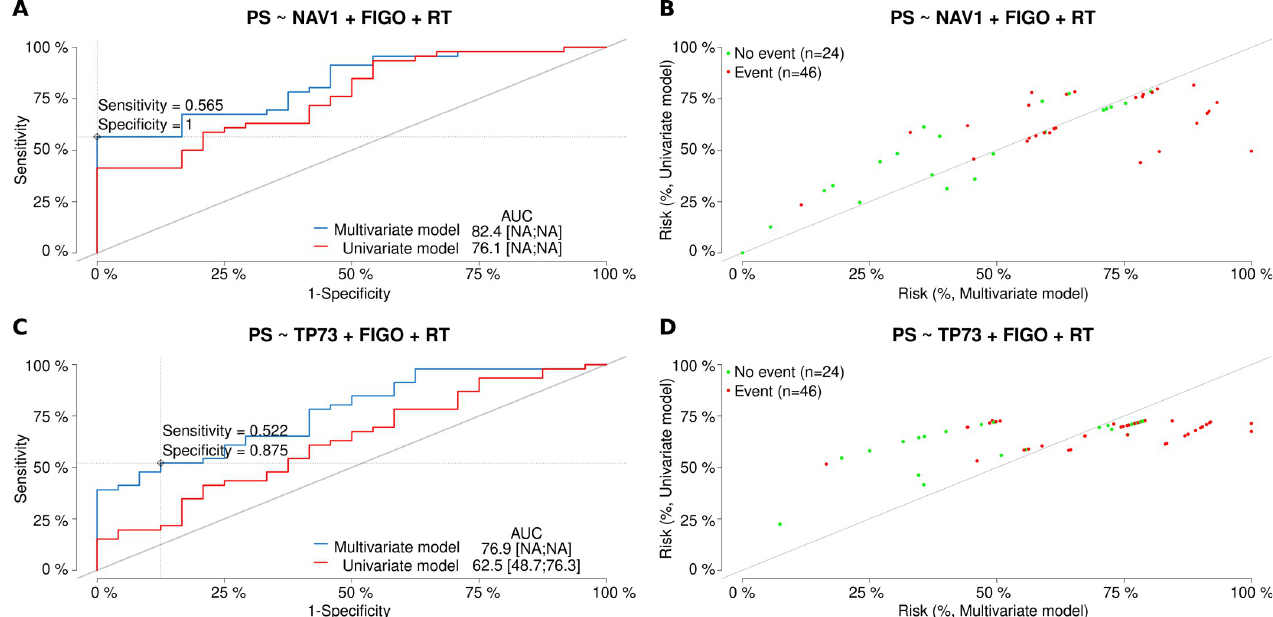
Fig 4. Characteristics and comparison of the logistic regression models (genes: NAV1 , TP73 ). The models allowed for the assessment of platinum sensitivity (PS) , depending on either a single independent variable (mRNA expression (exp)–the univariate model or three independent variables (exp, FIGO and RT)–the multivariate model. In Fig A, ROC curves for both models for the NAV1 gene are presented. An optimal cut-off point was calculated for the multivariate model based on the Youden index. Sensitivity and specificity for this cut-off point are also provided. In addition, AUC values [%] are listed alongside the 95% CI values, shown in square brackets, if calculable. Fig B compares discriminating capabilities of both the univariate and multivariate models for the NAV1 gene. Fig C and D depict the results of the same analyses as Fig A and B but for the TP73 gene. Abbreviations used: PS–Platinum Sensitivity; FIGO–clinical stage; RT–Residual